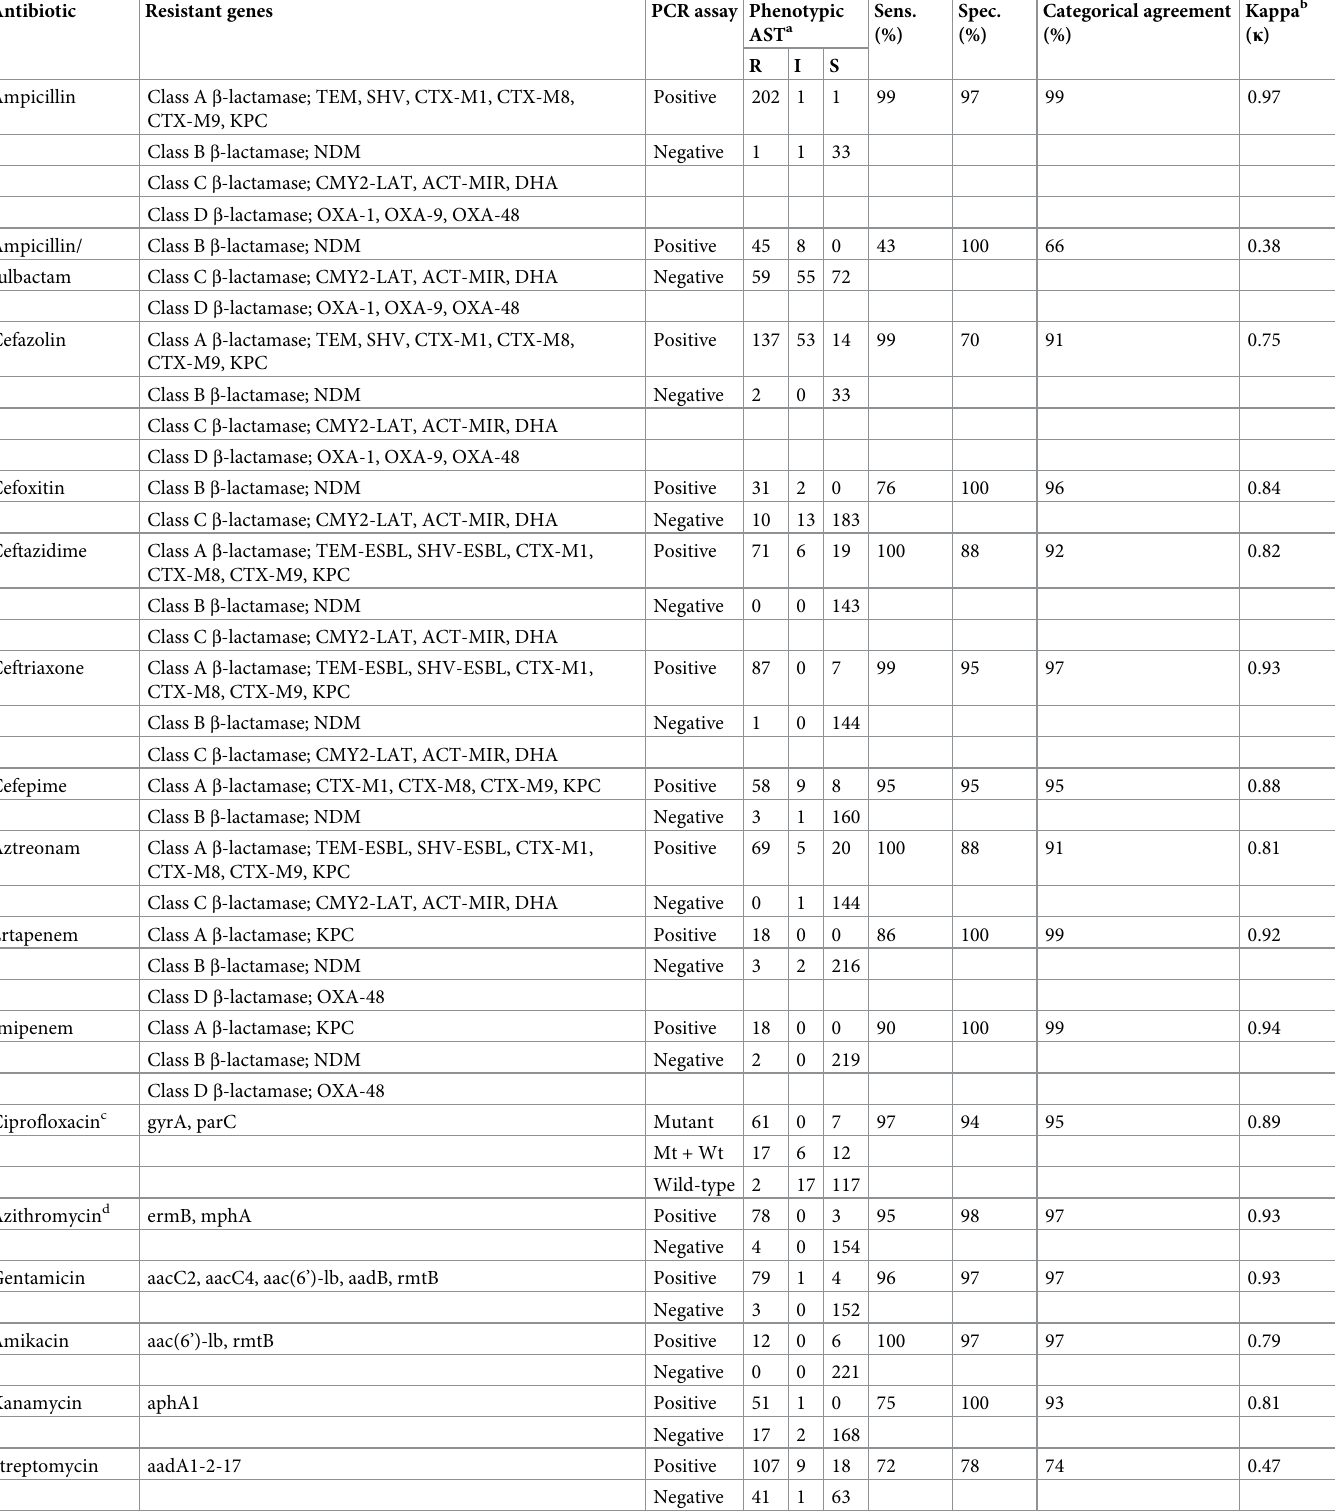
Table 2. Correlation between genotypic (AMR-PCR assay) and phenotypic AST of E . coli isolates (N = 239).